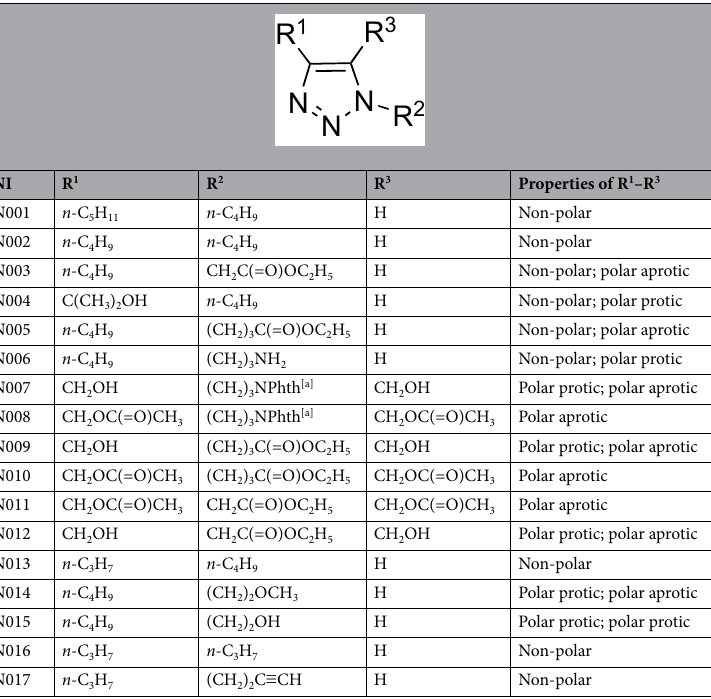
Table 1. Substituted 1,2,3-triazoles N001-N017 synthesized and tested as nitrification inhibitors (NI). [a] Phth =